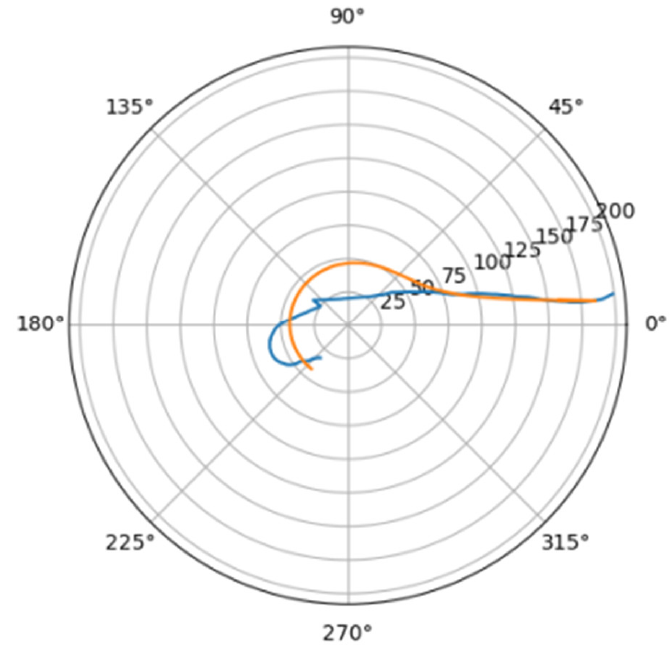
Figure 21. Approximation for lar_s.